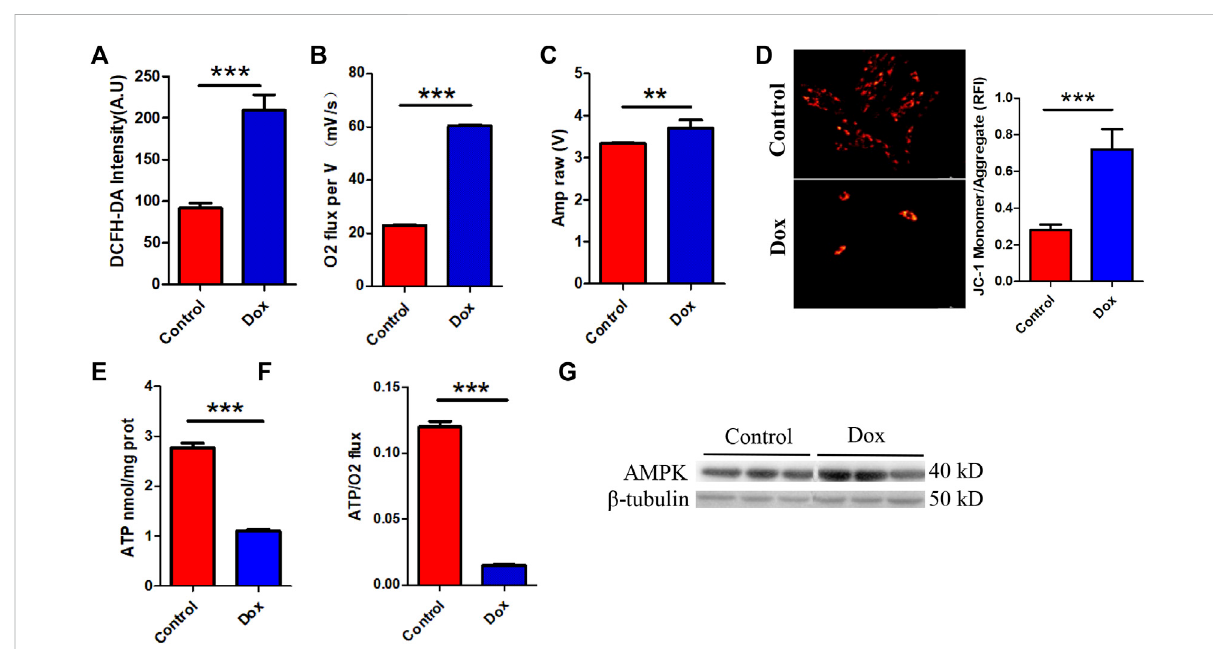
FIGURE 2 (A) Intensity of ROS staining in H9c2 cells. (B) Cardiac oxygen consumption in H9c2 cells. (C) The mitochondrial membrane potential. (D) JC-1 staining and bar graph. (E) ATP content in H9c2 cells. (F) The ATP production/oxygen consumption ratio in H9c2 cells. (G) The expression levels of AMPK and β -tubulin were measured in vitro by WB. Control vs. Dox: *** p < 0.0005, ** p < 0.005, * p < 0.05, mean ± SD. n = 6 –